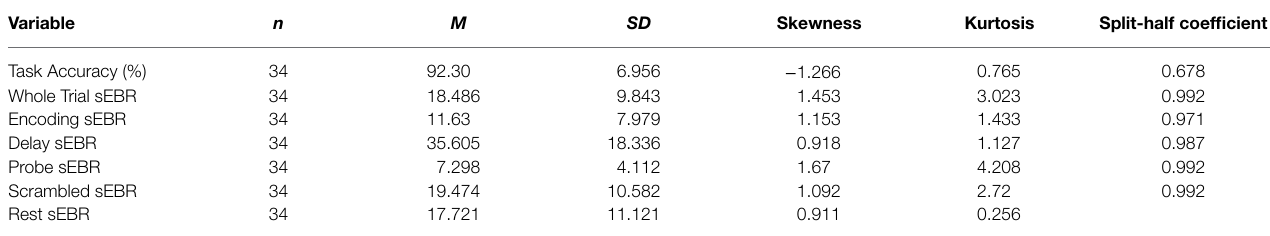
TABLE 2 | Descriptive statistics and split-half reliability for Experiment